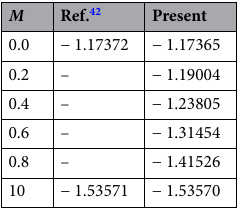
Table 1. Comparison of f ′′ ( 0 ) with Makinde et al. 42 for numerous valuations of M when (cid:31) 1 0 . n We Nr Re = = = = =